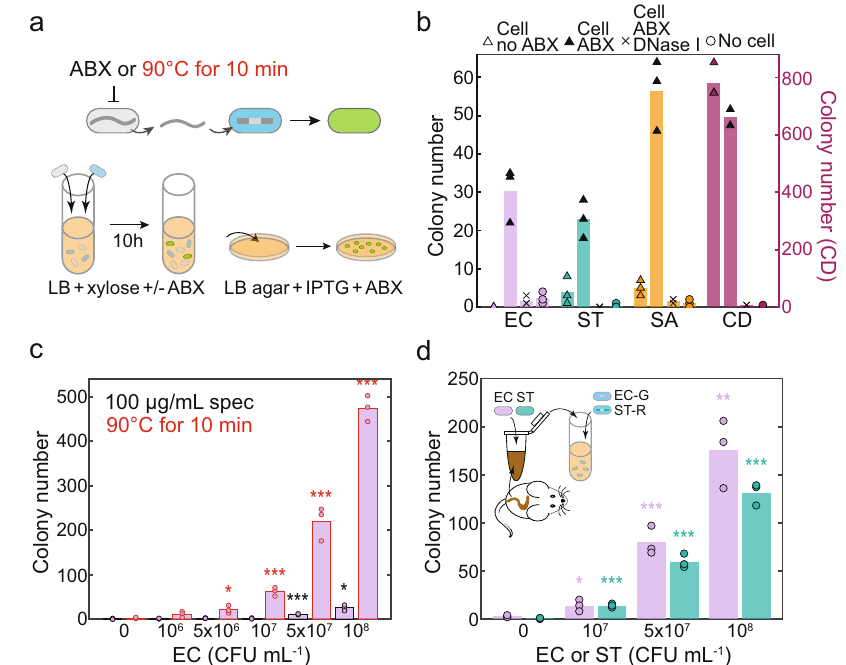
Fig. 4 | Cell-based DNA sensors can detect species without DNA extraction. a Schematic of experimental design for DNA detection in the co-culture. Addition of selective antibiotics (ABX) in the co-culture or pre-treated target strain by heat killing can enhance gDNA release and detection by the cell-based DNA sensor. b Bar plot of colony numbers of transformed EC, ST, SA, and CD sensors co- cultured with target strain only (open triangle), target strain and spectinomycin (100 µ g/mL)(solidtriangle),targetstrain,spectinomycin,and1unit/mLDNaseI(x), or spectinomycin only (open circle). Spectinomycin enhanced the detection of E. coli , S. typhimurium , and S. aureus in the co-cultures but was not required for the detection of C.dif fi cile .Addition of DNase I in the co-culturesubstantiallyreduced the number of transformed sensor colonies, indicating that the detection was via naturaltransformation. c BarplotofcolonynumbersofECsensorco-culturedwith varying amounts of spectinomycin-treated or heat-treated E. coli . Heat treatment